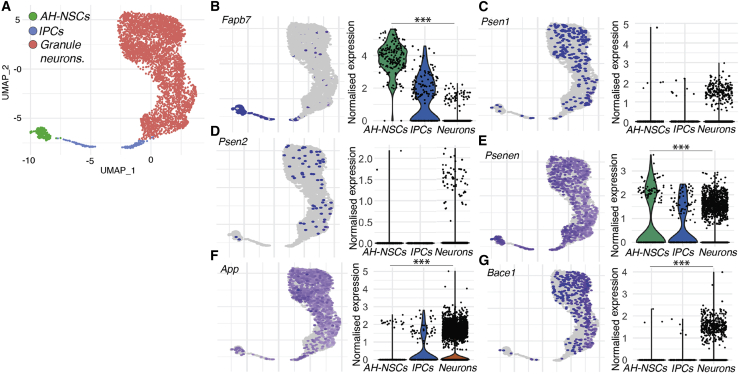
Expression of Notch Signaling Components and AD-Related Genes in the Mouse Adult Hippocampal Neurogenic Lineage(A) Low-dimensional representation of transcriptional space (UMAP plot), showing single-cell transcriptomes of adult hippocampal neural stem cells (AH-NSCs, green), intermediate neuronal progenitor cells (IPCs, blue), and granule neurons (red) derived from the hippocampus of postnatal mice from a publicly available dataset (Hochgerner et al., 2018).(B) Expression of the Notch signaling target gene Fabp7 is higher in NSCs than in neurons.(C–E) γ-secretase genes Psen1 and Psen2 are expressed in all cell types but below the threshold for differential gene expression analyses. The Psenen subunit of γ-secretase is significantly higher in NSCs than in neurons.(F) Expression of App is enriched in neurons compared with NSCs.(G) Expression of the β-secretase gene Bace1 is enriched in neurons.Wilcoxon rank-sum test, with the genome-wide false discovery rate (FDR)-corrected p value in (B)–(G). ∗∗∗p < 0.001, n.s., p > 0.05.